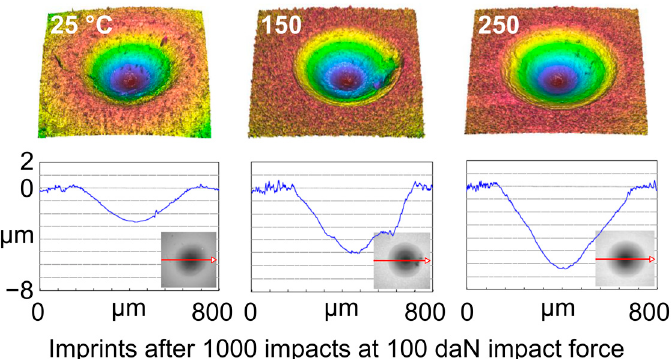
Figure 4. ( a ) Stress–strain curve of the applied HSS, attained via an FEM supported evaluation of nanoindentation results at elevated temperatures; ( b ) course of the yield (SY) and rupture stress (SM) of the HSS versus the temperature.